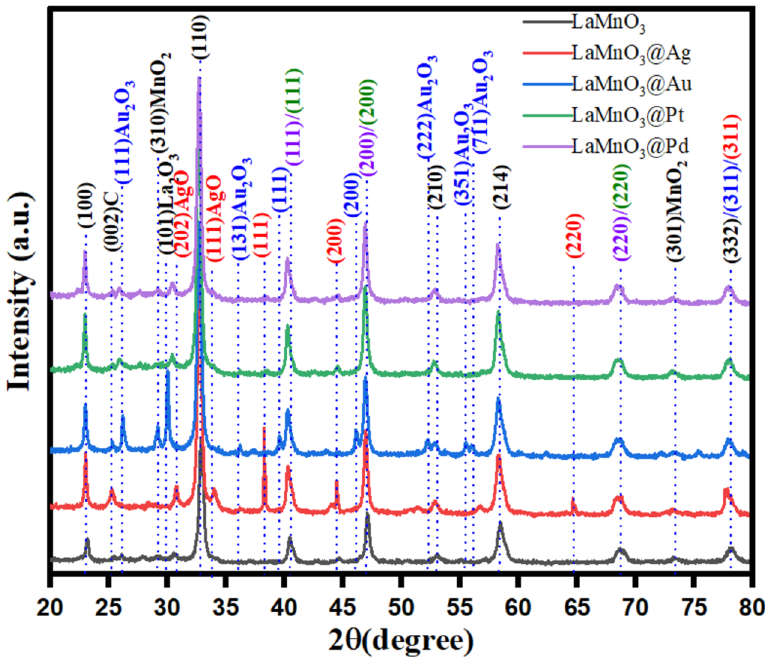
Figure 2. XRD patterns for the bulk and noble metal deposited LaMnO 3 nanocomposites.